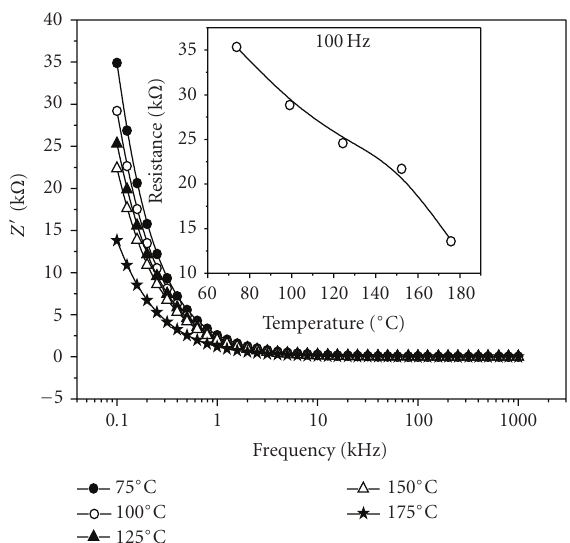
Figure 3: Variation of Z (cid:6) with frequency at di ff erent temperatures of PMN-35PT. Variation of resistance with temperature (inset).